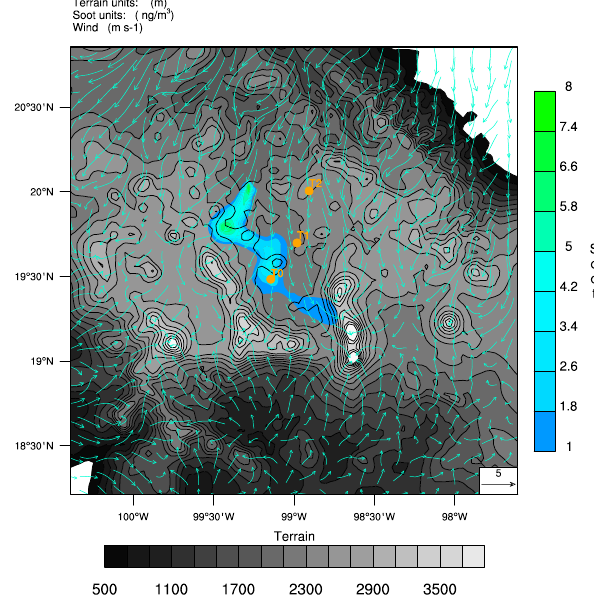
Fig. 6. Modeled plume of EC and surface wind fields for 23 March at